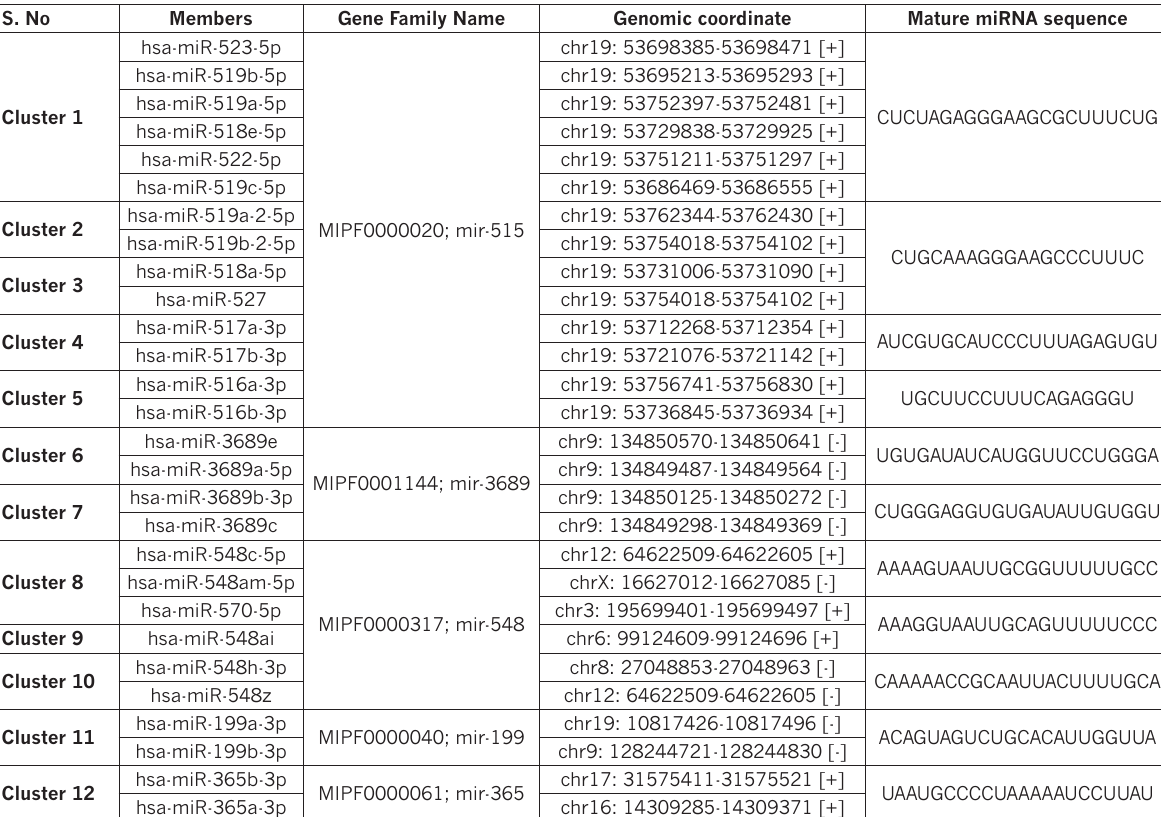
Table 1. List of miRNAs grouped into clusters, their genomic coordinates, gene family names and their matured miRNA sequences in Homo sapiens